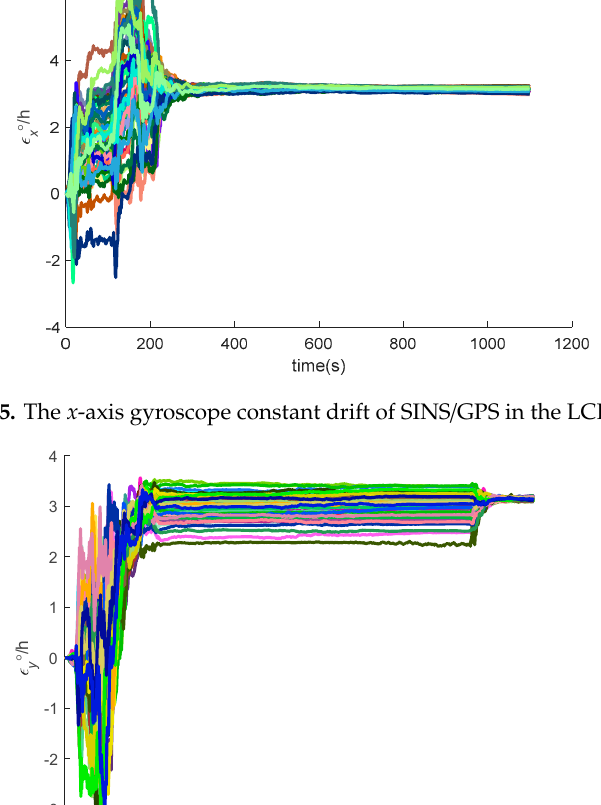
Figure 24. The z -axis position errors of SINS/GPS in the LCEF frame.